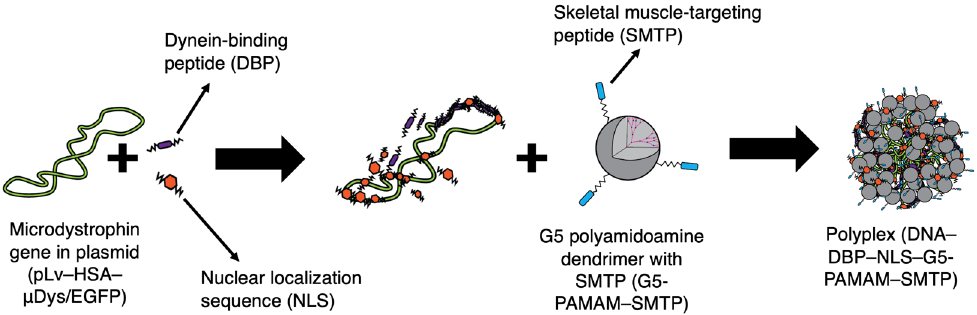
Figure 1. Components and synthesis order of peptide-modified dendrimer nanocarriers. Peptide structures are included in the Supplementary Information (Figure S1).